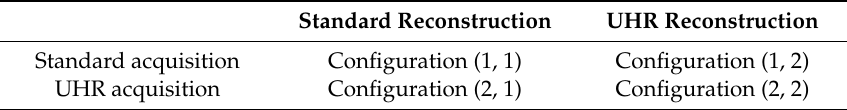
Table 2. Each configuration protocol with di ff erent resolution settings.